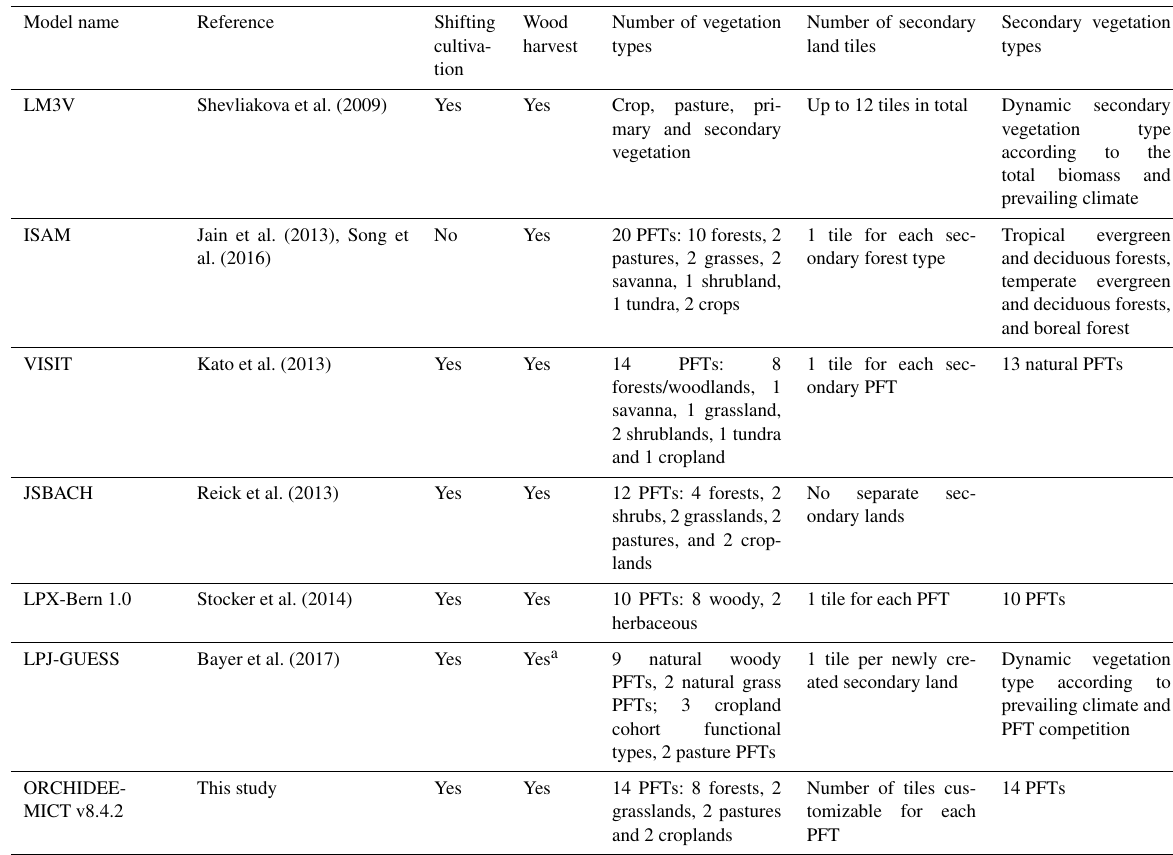
Table 1. An overview of DGVMs with implemented gross land use change (shifting cultivation) and forest wood